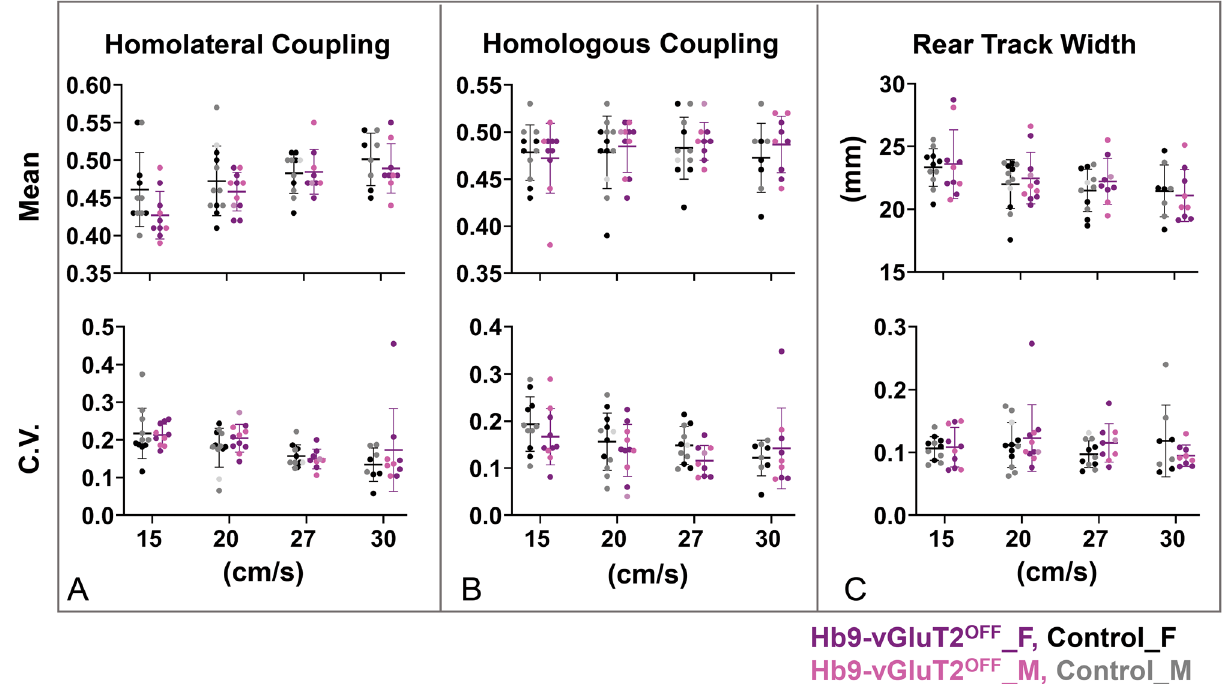
Figure 5. The pattern of locomotion in Hb9-vGluT2 OFF mice is similar to that of controls. ( A ) No significant difference was observed in homolateral coupling compared to controls (upper panel). There were no differences in the coefficients of variation (lower panel), except for difference between females and males in the control group at 15 cm/s (P = 0.04, Table 3). ( B ) Similarly, neither homologous coupling (upper panel) nor its coefficients of variation (lower panel) were different. ( C ) Rear track widths were also no different (upper panel), with similar coefficients of variation (lower panel). Numbers of mice used: total of 12 control mice, with n = 11 (5 females), 12 (5 females + 1 not specified), 11 (5 females + 1 not specified), and 8 (4 females) for 15, 20, 27, and 30 cm/s, respectively; and total of 11 Hb9-vGluT2 OFF mice: n = 10 (6 females), 11 (6 females + 1 not Hb9-vGluT2 OFF Female; Pink: Hb9-vGluT2 OFF Male; Lavender: Hb9-vGluT2 OFF sex not